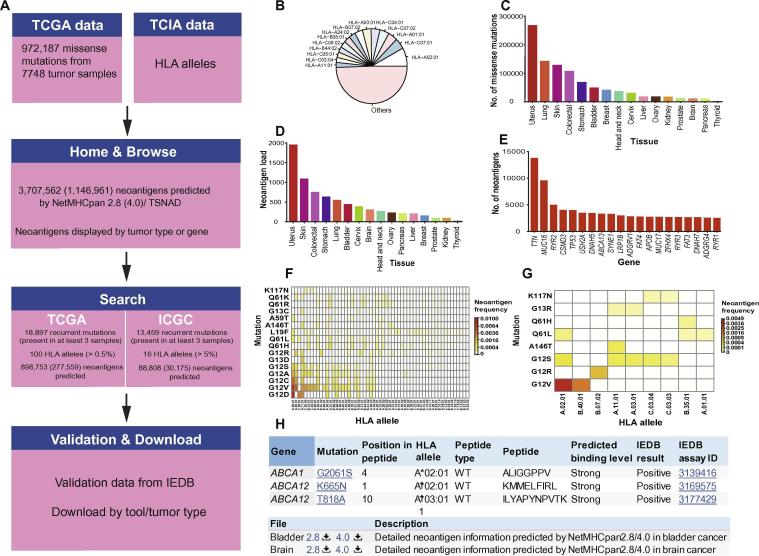
An overview of the TSNAdb web interfaceA. TSNAdb comprises five main components: (i) Home; (ii) Browse; (iii) Search; (iv) Validation, and (v) Download. The distribution of HLA alleles (B) and somatic missense mutations (C) extracted from TCGA and TCIA are listed. D. The average neoantigen loads across different tissues. E. Top 20 genes with predicted neoantigens in 7748 samples. F. The result of ‘Search’ page under the selection of “NetMHCpan2.8, KRAS, and TCGA”. G. The result of ‘Search’ page under the selection of “NetMHCpan2.8, KRAS, and ICGC”. H. Example of validation data from IEDB in ‘Validation’ page (top) and partial information on ‘Download’ page (bottom). The predicted binding level ‘Strong’ indicates strong binding with IC50 < 150 nM. TCGA, The Cancer Genome Atlas; TCIA, The Cancer Immunome Atlas; HLA, human leukocyte antigen; TSNAD, tumor-specific neoantigen detector; ICGC: International Cancer Genome Consortium; IEDB, Immune Epitope Database; WT, wild type.